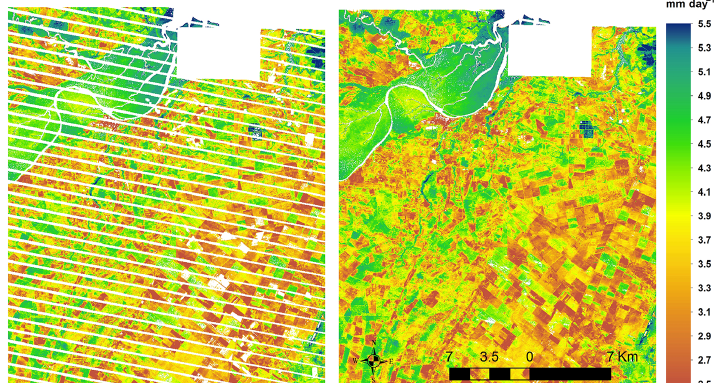
Figure 4. Example of gap-filling SLC-off stripes in a Landsat 7 ET image for DOY 96, 2013. The left image is Landsat-retrieved ET with stripes, while the right image has been gap filled using the method described in Sect. 2.2.3.